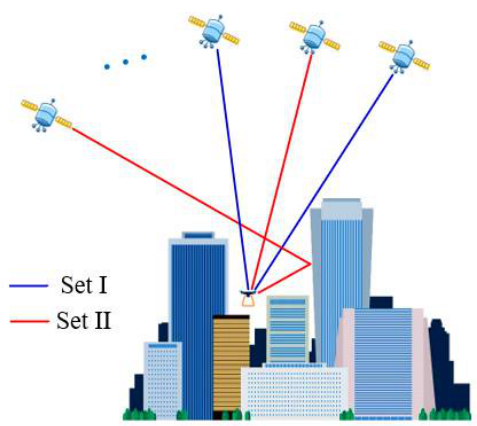
Figure 3. Normal satellite set (blue) and non-trustable satellite set (red).